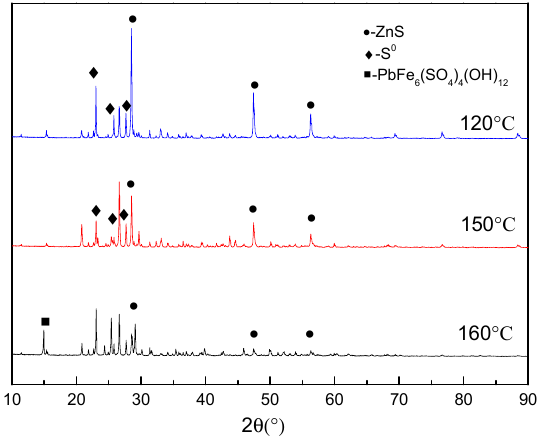
Figure 3. Effect of the leaching temperature on the extractions of Zn and Fe.